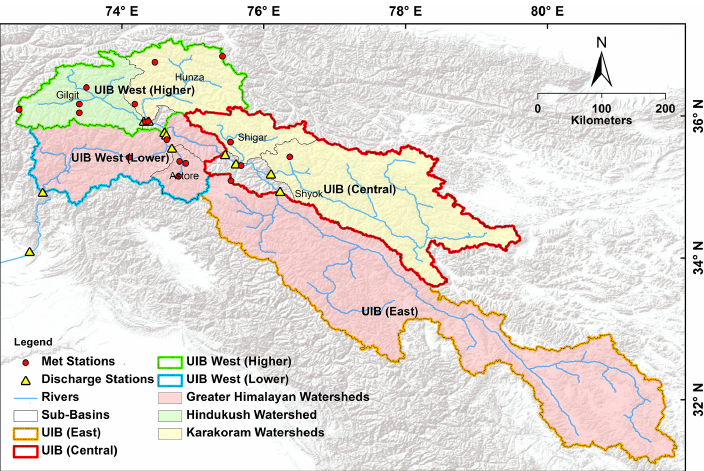
Figure 2. Hydrometric stations and the subregions considered for field significance.